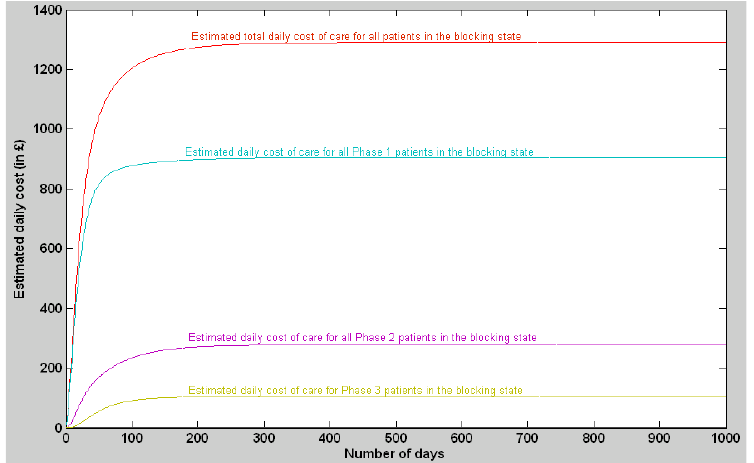
Figure 16. The estimated daily cost of care of patients in each phase of the stroke care unit (for mean discharge delay τ = 10 days). discharge delay τ = 10